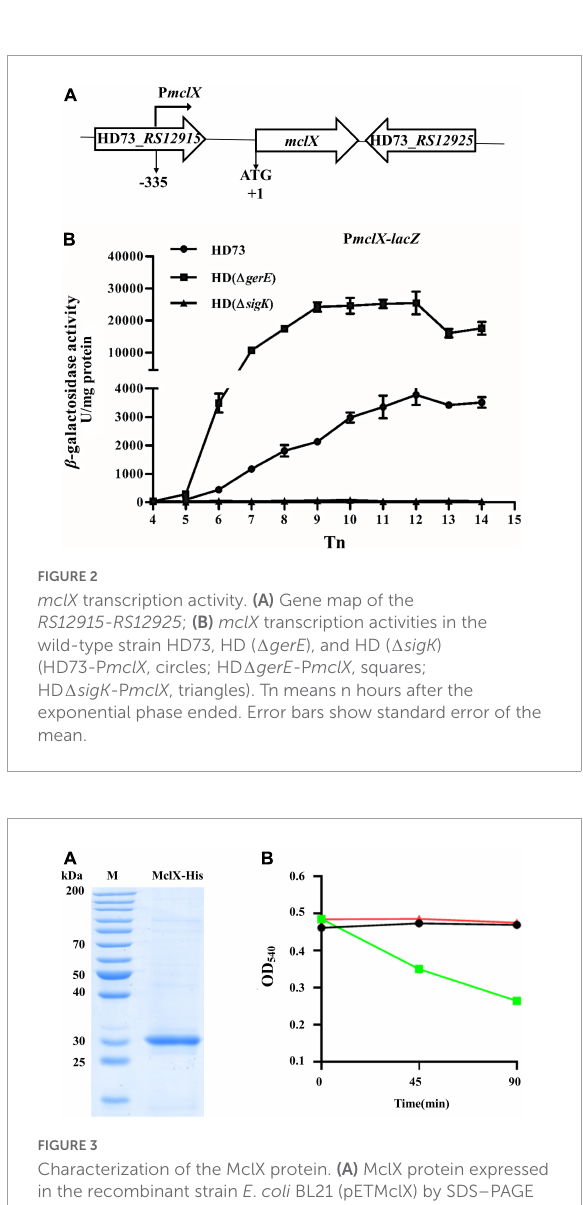
FIGURE3 Characterization of the MclX protein. (A) MclX protein expressed in the recombinant strain E . coli BL21 (pETMclX) by SDS–PAGE analysis. M, protein marker, 26614; (B) purified MclX protein was unable to hydrolyze the wild-type strain HD73 cell wall. The strain HD73 cell wall was mixed with MclX protein (triangles). CwlC protein (known cell wall hydrolase) plus cell wall was used as a positive control (squares), and the cell wall itself was used as a negative control